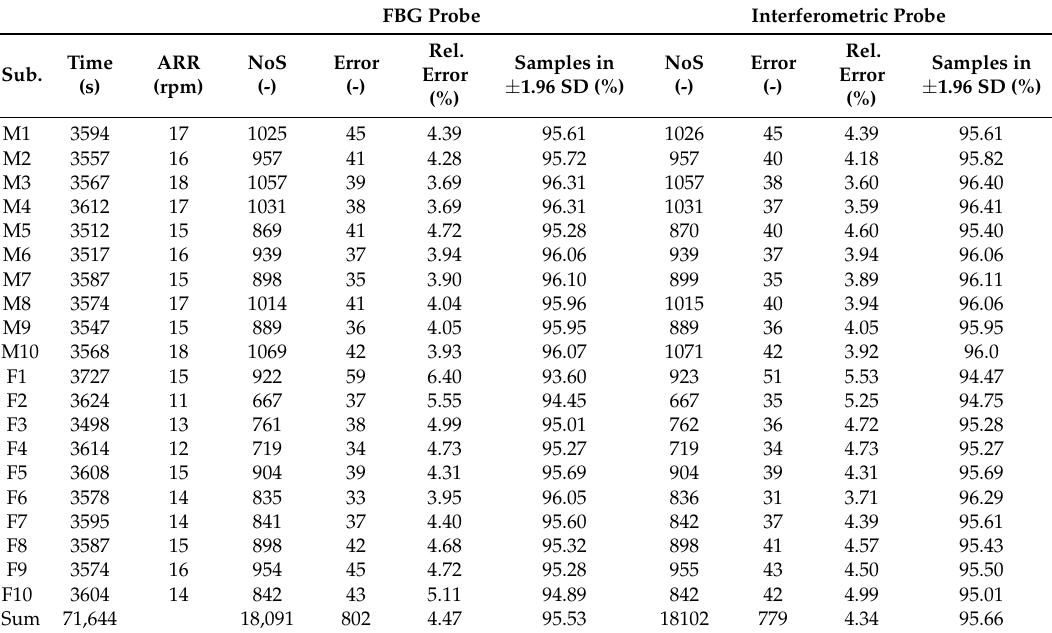
Figure 13. ( a ) B–A plot of M1 subject—FBG probe vs. PERT; ( b ) B–A plot of M1 subject—FOI probe vs. PERT; ( c ) B–A plot of F1 subject—FBG probe vs. PERT; ( d ) B–A plot of F1 subject—FOI probe vs. PERT. Table 3. Summary of respiratory